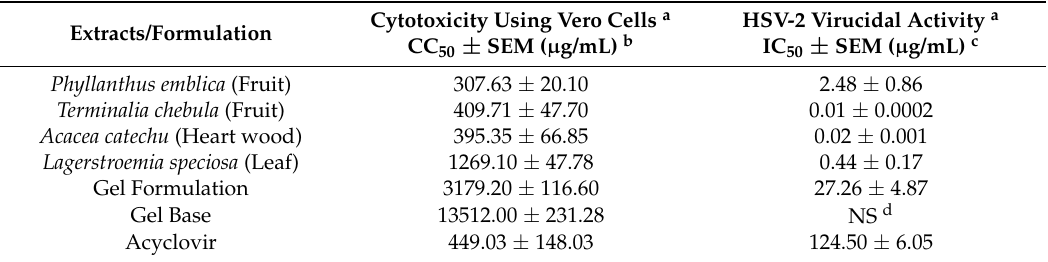
Figure 2. Anti-HIV-1 activity of the gel formulation. TZM-bl cells were cultured overnight at 37 °C in humidified atmosphere of 5% CO 2 followed by infection with HIV-1 NL4.3 at an multiplicity of infection (MOI) of 0.05 in presence or absence of gel formulation and processed for determination of anti-HIV-1 activity as described in Materials and Methods . Nevirapine (2 µg/mL) was used as positive control and gel base (31,200 µg/mL) was used as negative control. Y-axis represents the percent inhibition of HIV-1 infection and X-axis represents the varying concentrations of the gel formulation. Data is expressed as mean ± SEM of 3 different experiments performed in duplicates. Significance of the gel formulation, Nevirapine, and gel base was calculated by one way analysis of variance (ANOVA) with respect to untreated control. * p < 0.05, ** p < 0.005. Table 1. Cytotoxicity of the 50% ethanolic extracts prepared from different plants and gel formulation using Vero cells and their anti-HSV-2 activity in virucidal assay.